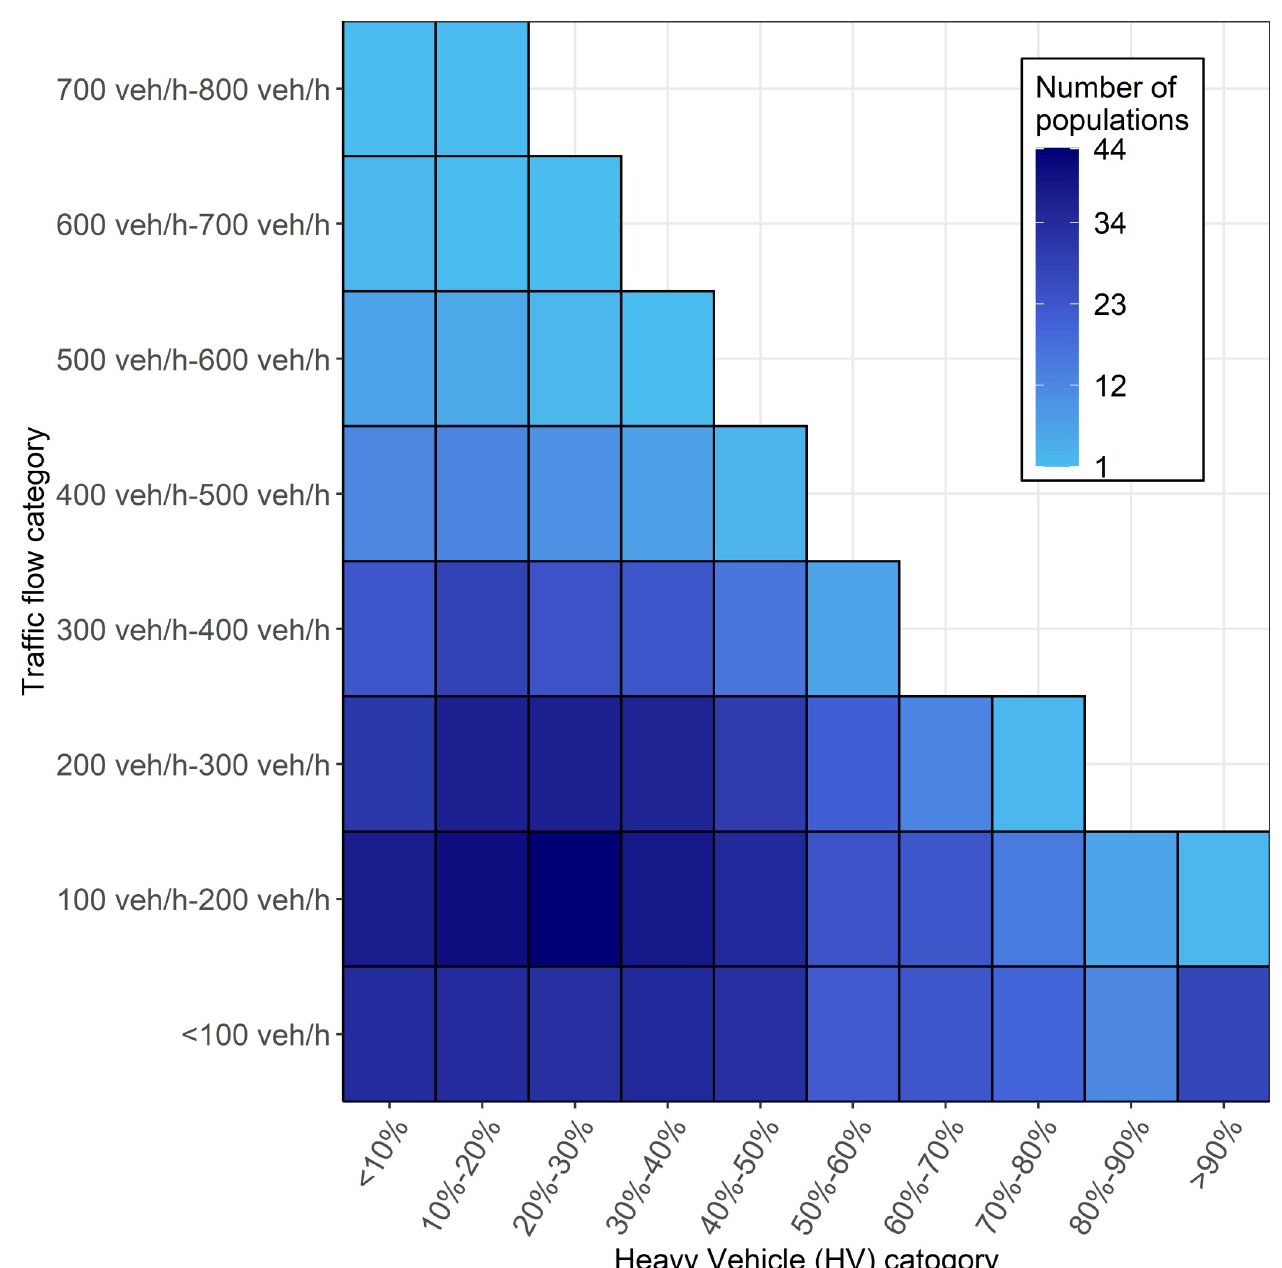
Fig 11. Number of populations recorded in terms of the traffic flow and HV